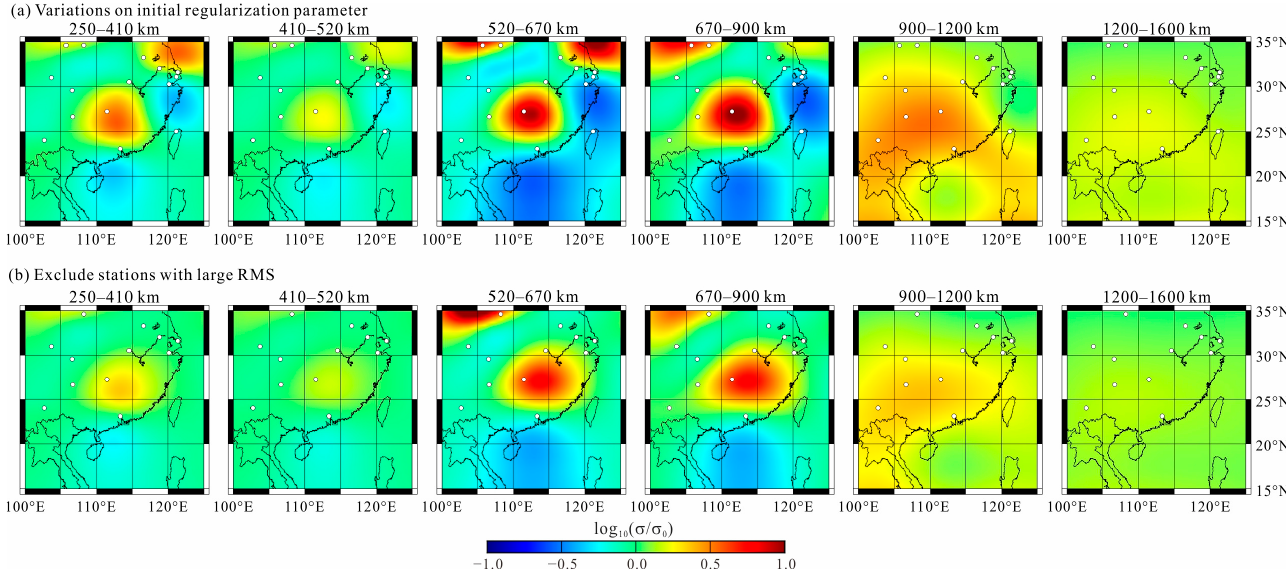
Figure 6. The results of inversions with an initial regularization parameter equaling 100 ( a ) and stations excluding responses with a large RMS ( b ).